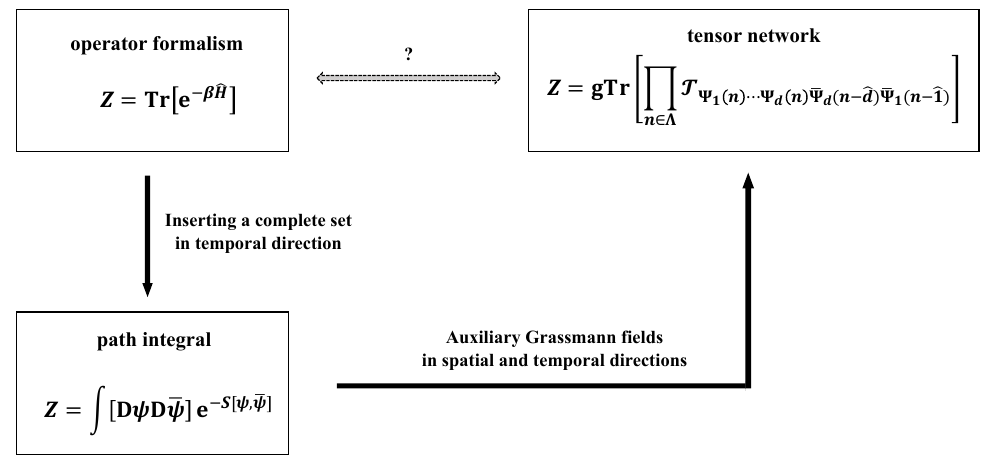
Figure 9 . A possible relationship between the path integral, operator formalism, and tensor